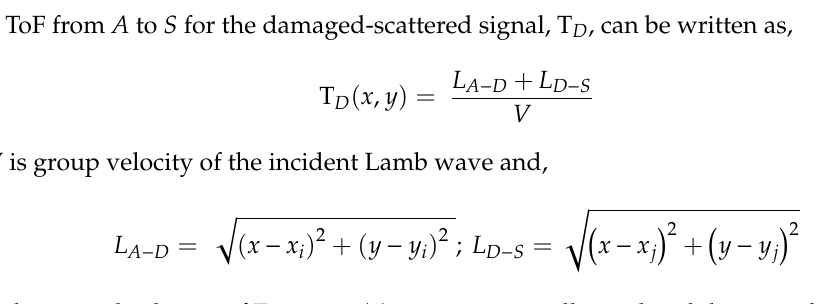
Figure 1. Time-of-flight (ToF)-based damage